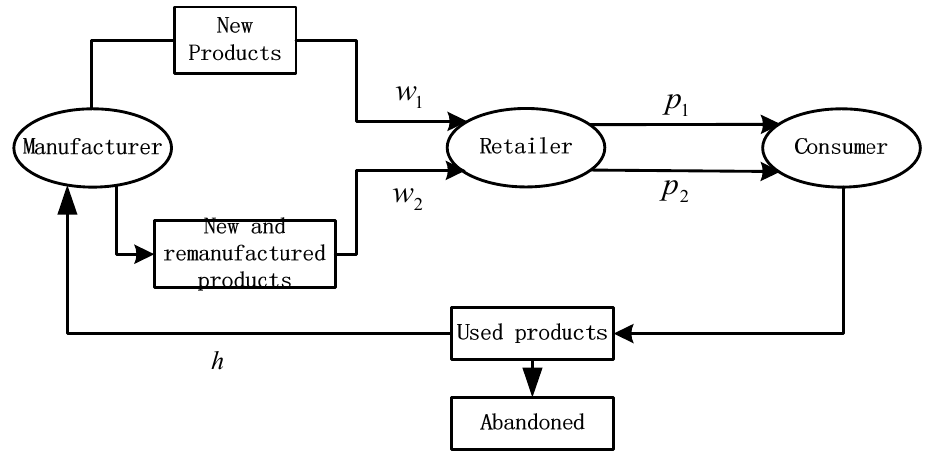
Figure 1. Model structure diagram.